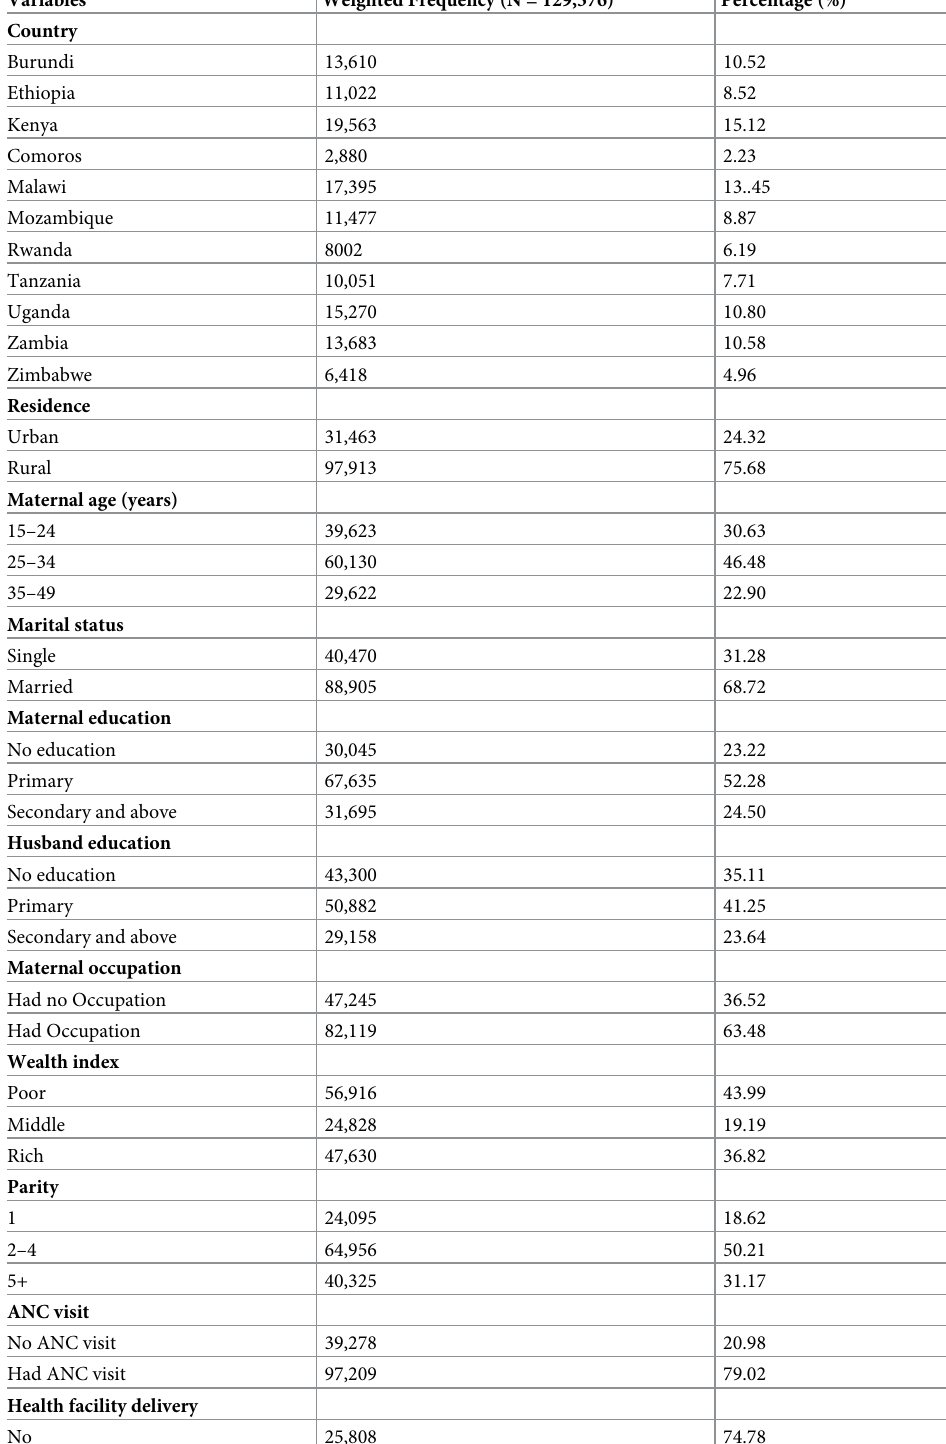
Table 2. Socio-economic, demographic, maternal, and obstetric characteristic of respondents in the 11 East Africa Countries from 2011 to